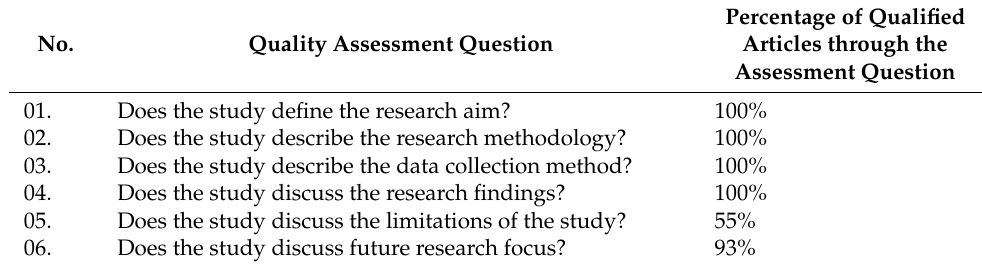
Table 1. Quality assessment of SLR.